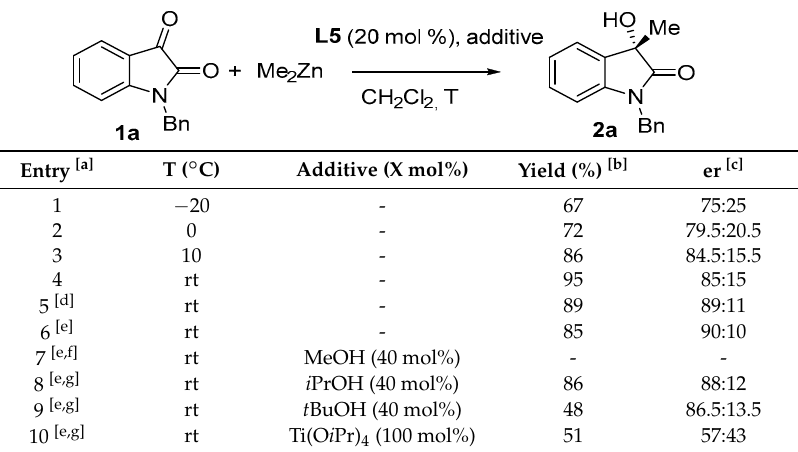
Table 2. Optimization of the reaction conditions.